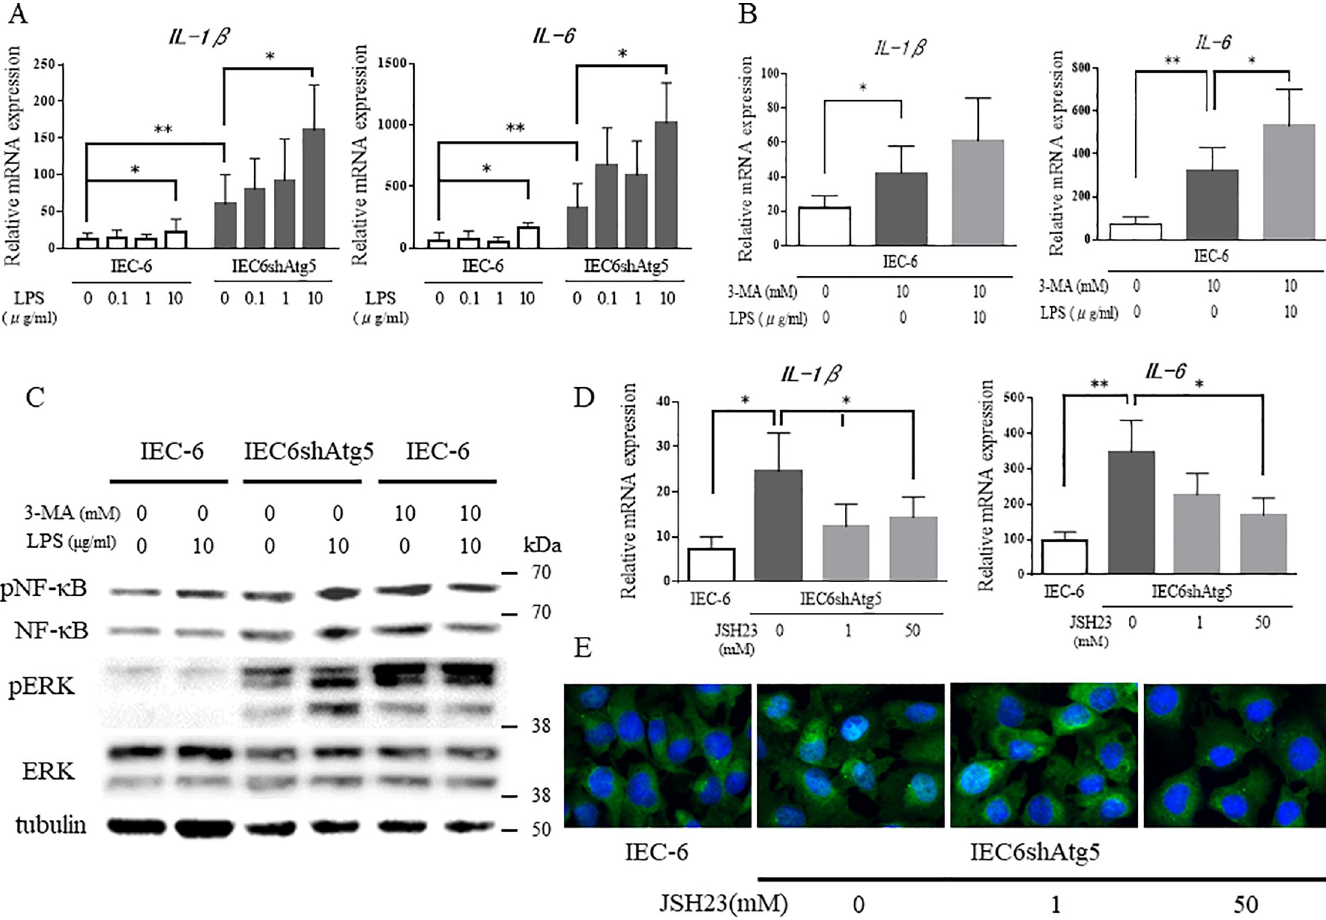
Fig 4. Inhibition of autophagy induces the expression of proinflammatory cytokine genes and the phosphorylation of NF- κ B. (A) mRNA expression of proinflammatory cytokine genes in IEC-6 and IEC6shAtg5 cells after LPS treatment. Cells were treated with 0, 0.1, 1, and 10 μ g/ml LPS for 24 h, and mRNA expression of IL-1 β and IL-6 were determined by qPCR. (B) mRNA expression of proinflammatory cytokine genes in IEC-6 cells with or without LPS or 3-MA treatment. Cells were treated with or without LPS (10 μ g/ml) or 3-MA (10 mM) treatment for 24 h, and mRNA expression of IL-1 β and IL-6 were determined by qPCR. (C) pNF- κ B p65 and pERK protein expression levels in IEC-6 and IEC6shAtg5 cells with or without LPS or 3-MA treatment. Cells were treated with or without LPS (10 μ g/ml) or 3-MA (10 mM) for 24 h, and pNF- κ B p65 and pERK protein expression levels were determined by Western blot analyses. Experiments were replicated at least three times, and the representative figures are shown. (D) mRNA expression of proinflammatory cytokines in IEC-6 and IEC6shAtg5 cells after NF- κ B inhibition. Cells were treated with or without an inhibitor of NF- κ B transcriptional activity, JSH23, and mRNA expression of IL-1 β and IL-6 was determined by qPCR. Experiments were replicated at least three times. � p < 0.05, �� p <